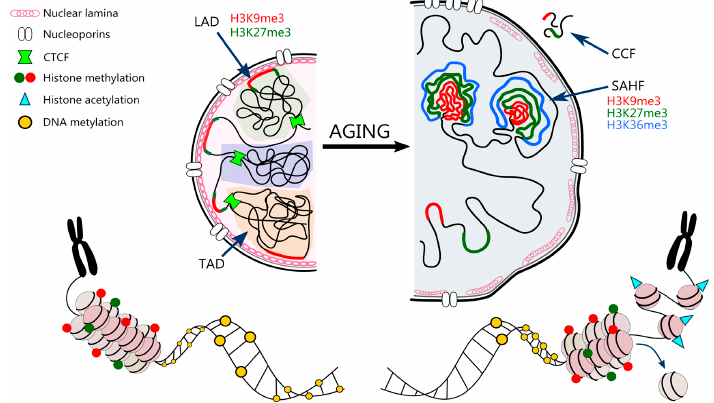
Figure 3. Nuclear and chromatin architecture changes in ageing and senescent cells. The nucleus of a proliferating cell contains a highly condensed chromatin enriched in methylated histones and hypermethylated DNA. The chromatin is compartmentalized into topologically associated domains (TADs) enclosed by CTCF protein and cohesin (not shown). Heterochromatic and gene-poor regions, characterized by the presence of H3K9me3 and H3K27me3, are in close contact with nuclear lamina (NL) forming lamina associated domains (LADs) contributing to the overall stabilization of the nuclear structure. During ageing / senescence DNA becomes globally hypomethylated with exception of promoters of particular genes, which may be hypermethylated. As a result, the gene expression pattern is significantly altered. Similarly, nucleosomes display a general loss of histones leading to loosely compacted euchromatin. Reduced compaction is also a result of accumulation of acetylated residues on histone tails and reduction of their methylation. OIS cells exhibit local condensation and redistribution of heterochromatin in the form of SAHFs. SAHFs emerge from detachment of heterochromatin from the nuclear lamina (due to downregulation of Lamin B1 and accumulation of dysfunctional prelamin A and progerin) and have a layered structure with a H3K9me3 rich core encircled with H3K27me3. On the outside, fragments of active chromatin are found (H3K36me3). Moreover, the local accumulation of nucleoporins prevents deposition of heterochromatin near the nuclear envelope. Disturbances in NL structure also result in cytoplasmic chromatin fragments that contain DNA and repressive histone